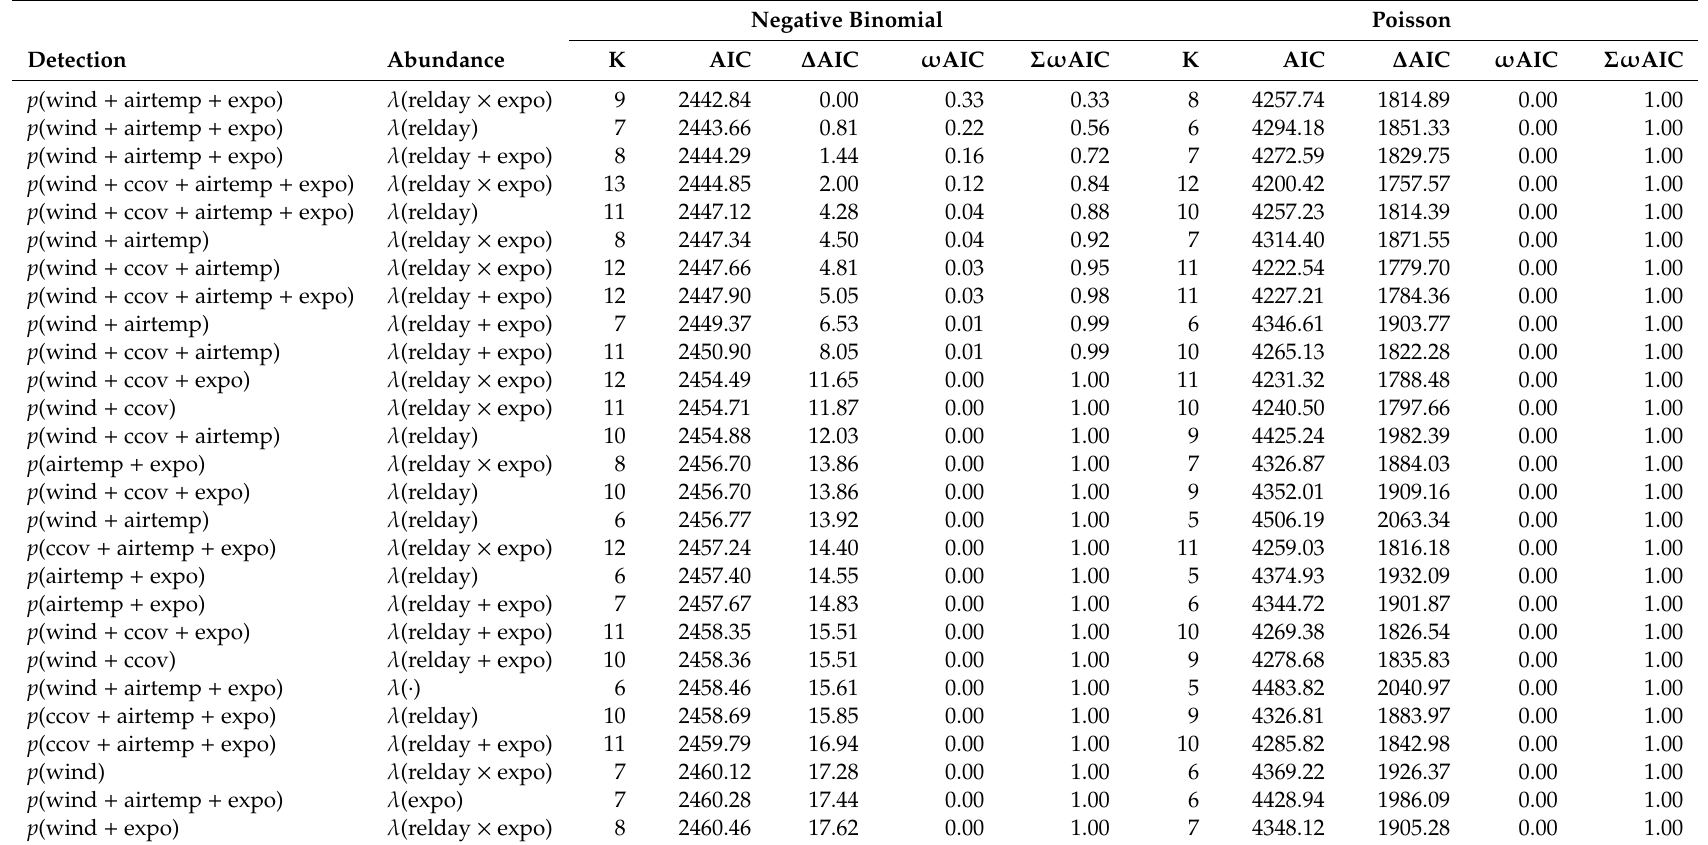
Table A1. Full model selection table for the negative binomial (left side) and Poisson parameterizations of the N-mixture model. Here we show all 40 models for each parameterization. The models are ranked according to their negative binomial AIC scores (i.e., the AIC-preferred model, lowest is better). The Detection ( p ) and Abundance ( λ ) model formulations are provided, as is the number of parameters in the model (K), the AIC score, the di ff erence in AIC relative to the top model ( ∆ AIC), the AIC weight ( ω AIC) which is a measure of relative model support, and the cumulative AIC weights ( Σ ω AIC). The ‘*’ denotes interactions between terms and ( · ) denotes the intercept only (or null)